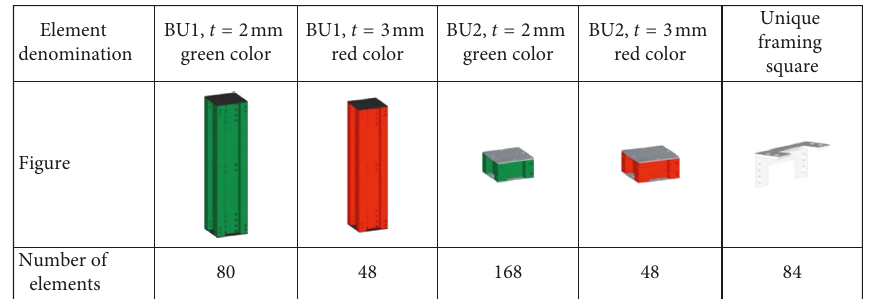
Figure 24: Number of industrialized elements needed to generate a structure that allows a diaphanous DV volume (4.8m